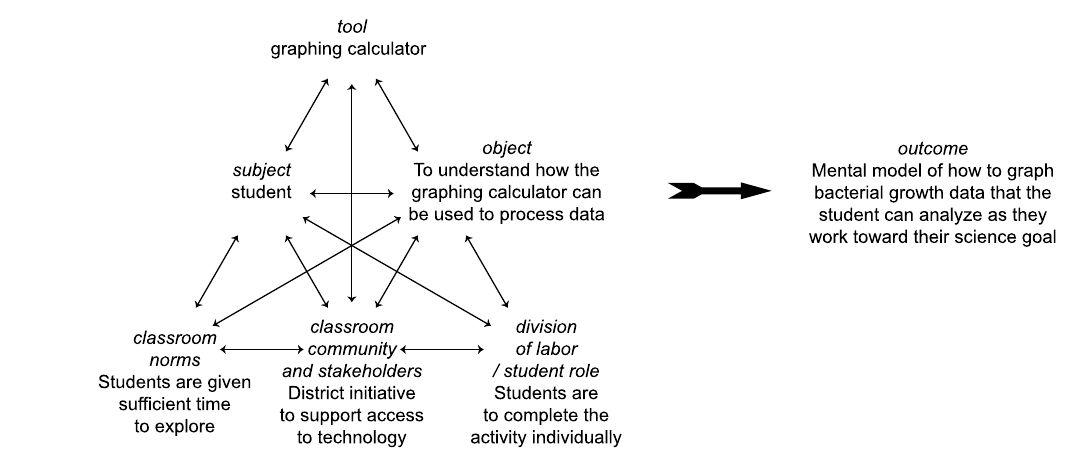
Fig. 3 Reflective use of a computational tool for data processing activity